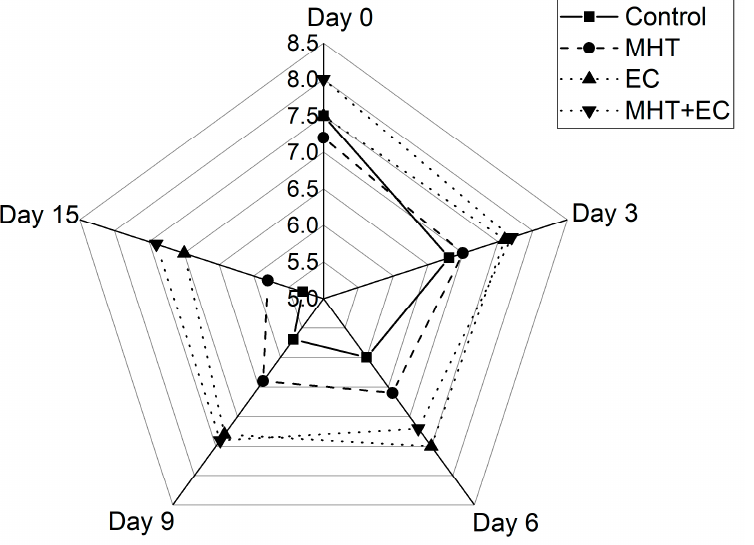
Figure 9. Radar chart representing mean scores of the overall visual quality of control and treated minimally processed green onions during storage.